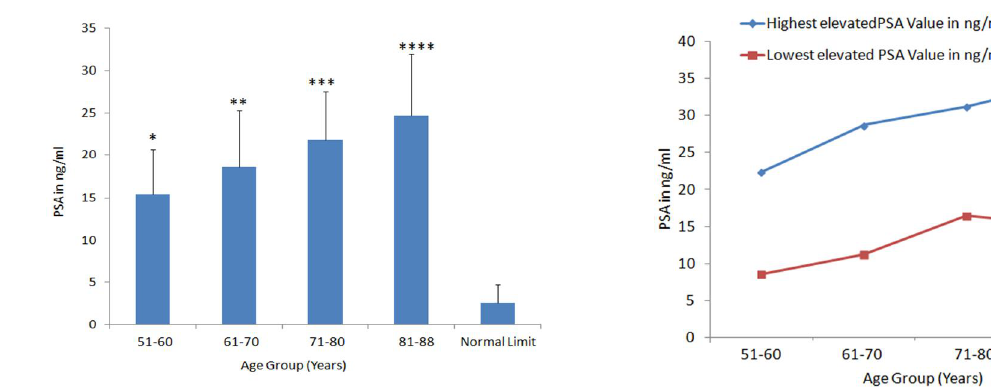
Figure 2. The highest and lowest PSA level in different group of patients Blood samples of patients of different age group were tested for PSA level. The highest and lowest PSA level in all age group of patients, who showed elevated level of PSA.